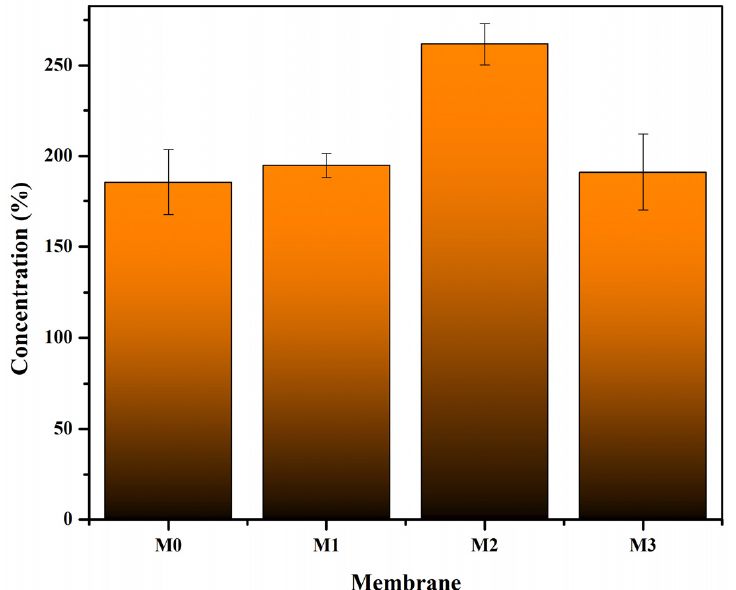
Figure 8. Profile of lactalbumin concentration for pure (M0) and the modified PVDF membrane (M1: PVDF + Pol, M2: PVDF + Pol + S-CnT, and M3: PVDF + Pol + M-CnT. The filtration test was designed as a crossflow filtration module with an operating pressure of 1 bar, and the concentration of lactalbumin was analyzed after 1 h